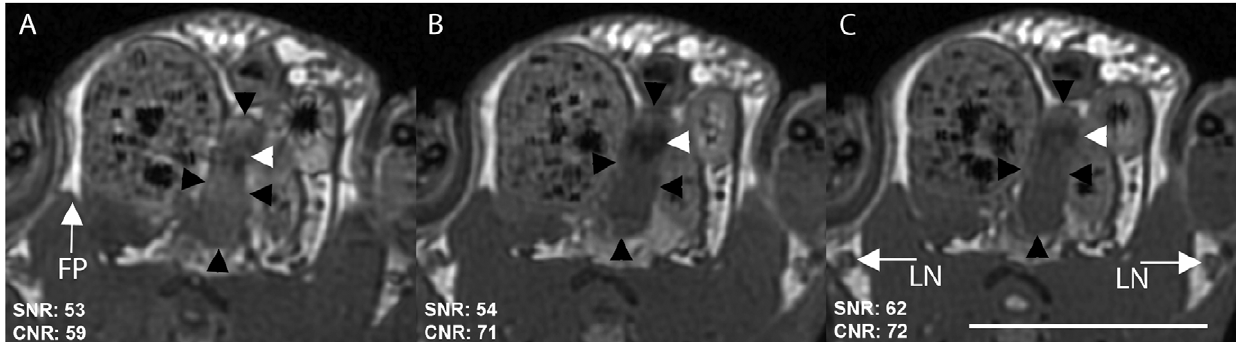
Figure 1. Effect of phase cycling and averaging on ex vivo prostate image quality. Cropped and enlarged sections of axial scans: A: 2 PC, 4 NEX, B: 4 PC, 2 NEX, C: 8 PC, 1 NEX. Black arrowheads indicate prostate, white arrowheads urethra, FP is the fat pad used for CNR measurements and LN are the inguinal lymph nodes. Scale bar is 1 cm. Axial scan, FOV 4 6 4 cm, 200 m m isotropic resolution, TR/TE=3.9/2.0 ms, FA 30 u , BW 6 62.5 kHz, 20 minutes.